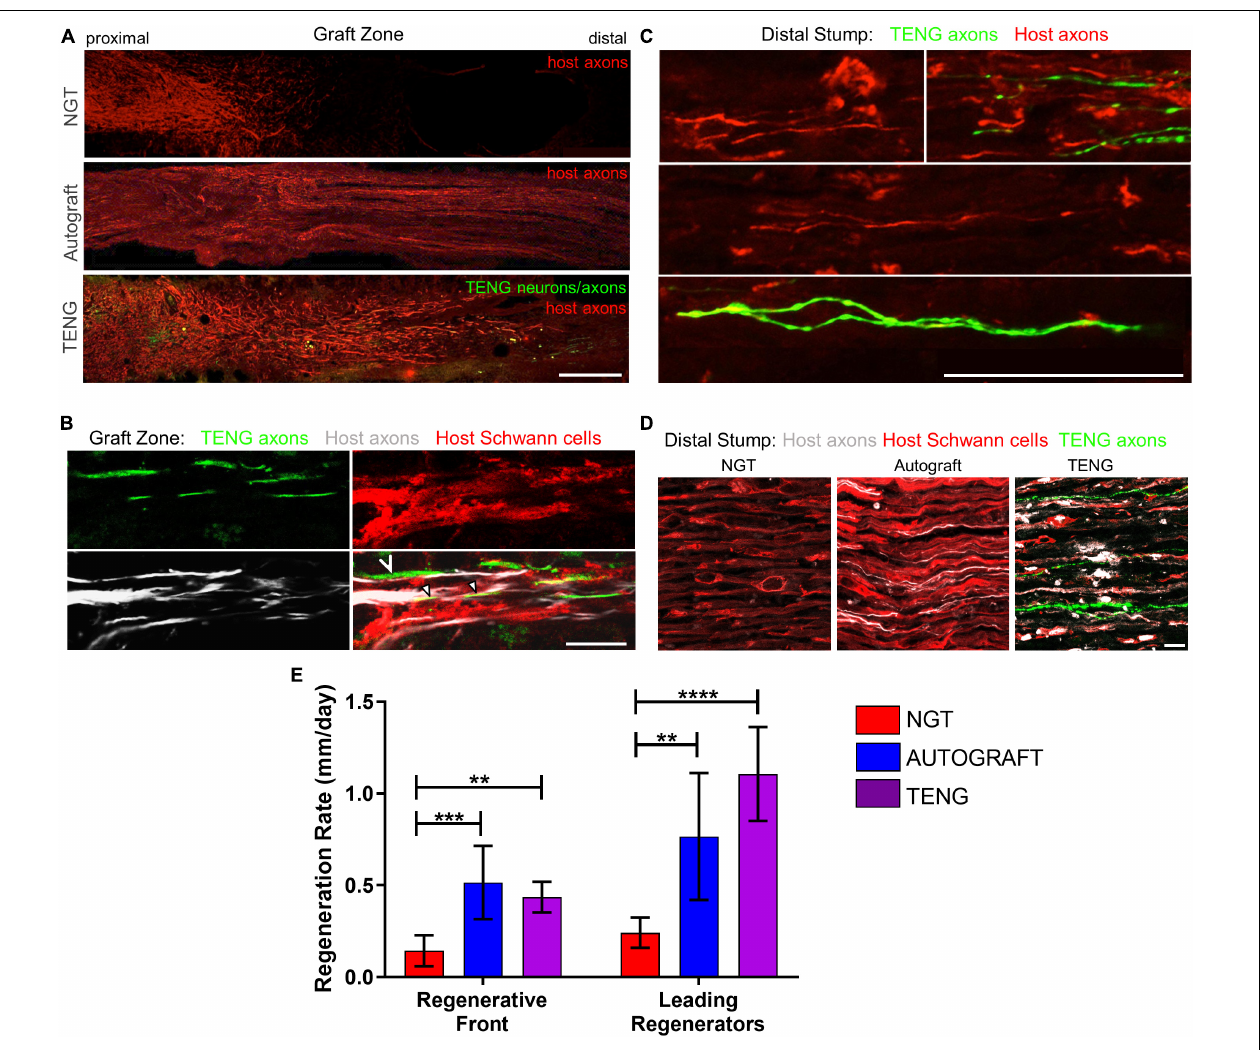
FIGURE 4 | TENGs accelerate host axon regeneration. Longitudinal sections (A,B) across the graft zone and/or (C,D) into the distal stump at 2 weeks following repair using an NGT, a reverse autograft, or TENG. (A) Axon regeneration as labeled by SMI31 (red, host axons) and GFP (implanted TENG neurons/axons) showing the “regenerative front” – main bolus of regenerating axons – for each repair group. Regeneration through an NGT yielded retarded and disorganized axonal extension. Regeneration through a reverse autograft was highly organized owing to the presence of aligned autologous SCs throughout the graft (not shown). Regeneration through TENGs showed host axons following the length of the GFP-labeled TENG axons, with greater penetration and more organization than that found following NGT repair. Scale bar: 1000 µ m. (B) Clear discrimination of TENG and host axons, as well as host SCs, across the graft zone. In addition to direct AFAR (hollow arrowhead), host SCs also migrated and organized along TENG axons (solid arrowheads), creating a “tripartite” regenerative complex of TENG axons: host axons: host SCs. Scale bar: 10 µ m. (C) Following TENG repair, a group of host “Leading Regenerator” axons was present in the distal stump – far afield from the “Regenerative Front” – and were seen along with TENG axons that had also penetrated into the distal stump. Scale bar: 50 µ m. (D) These accelerated “Leading Regenerator” axons were present following TENG or autograft repair, but were always absent following NGT repair. (E) Quantification of axon regeneration (mean ± standard deviation). Host “Regenerative Front” and “Leading Regenerators” were statistically equivalent following TENGs and autografts repair, and both were superior to NGT repair (** p < 0.01, *** p < 0.001, **** p <